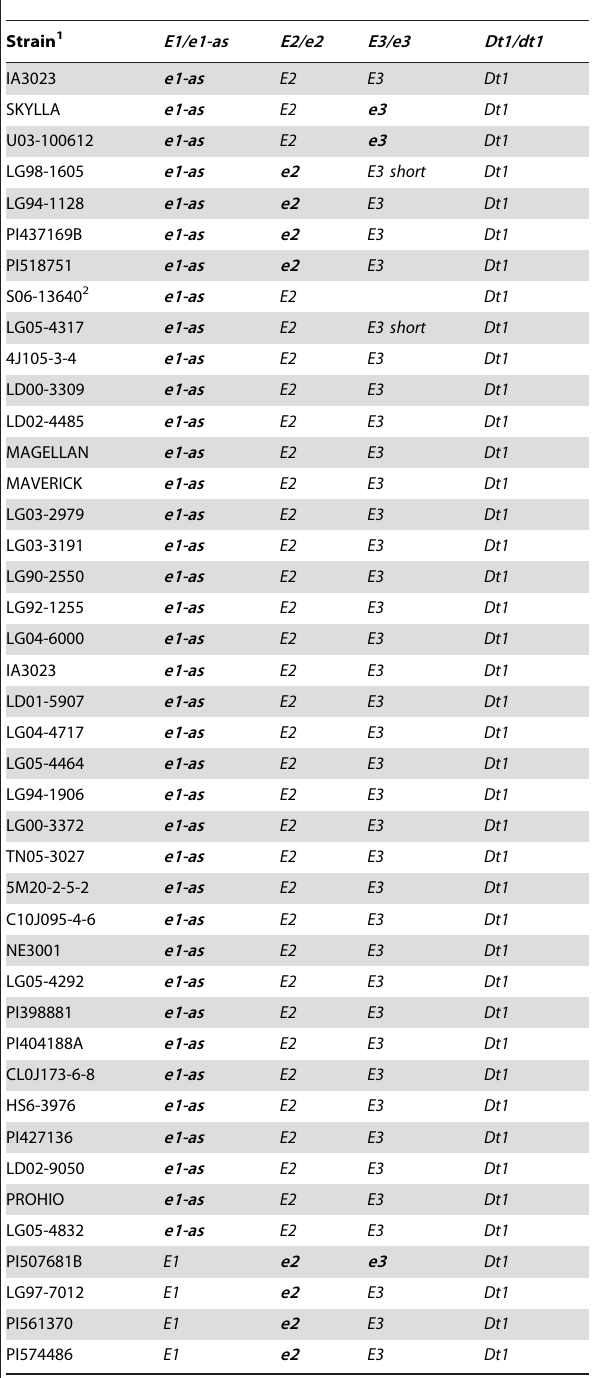
Table 5. Maturity and growth determinate genotypes for the 41 NAM